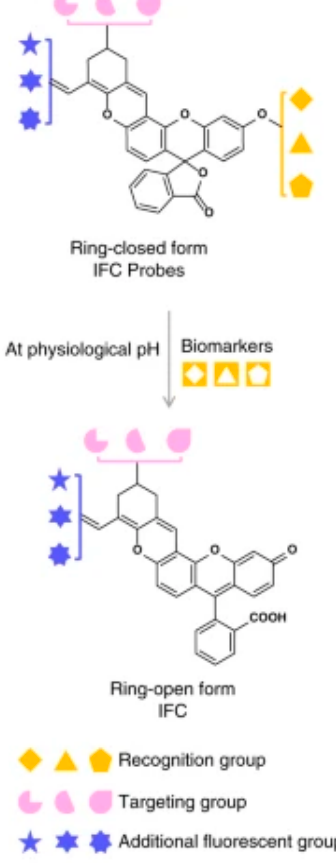
Figure 25. Chemical structures of 97 – 99 with different biomolecular-recognition groups as quanti- tative sensing platform (IFC stands for integrated fluorescein with chromene). Reprinted/adapted from [83].